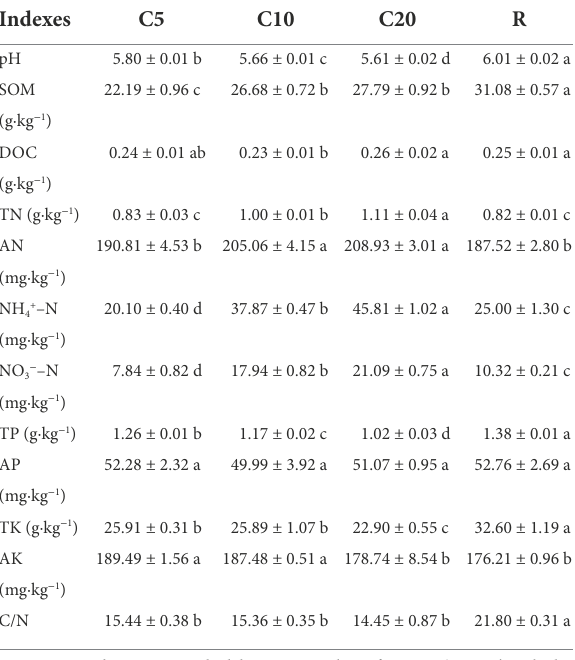
TABLE 2 Soil chemical indexes of soybean continuous and rotational cropping.